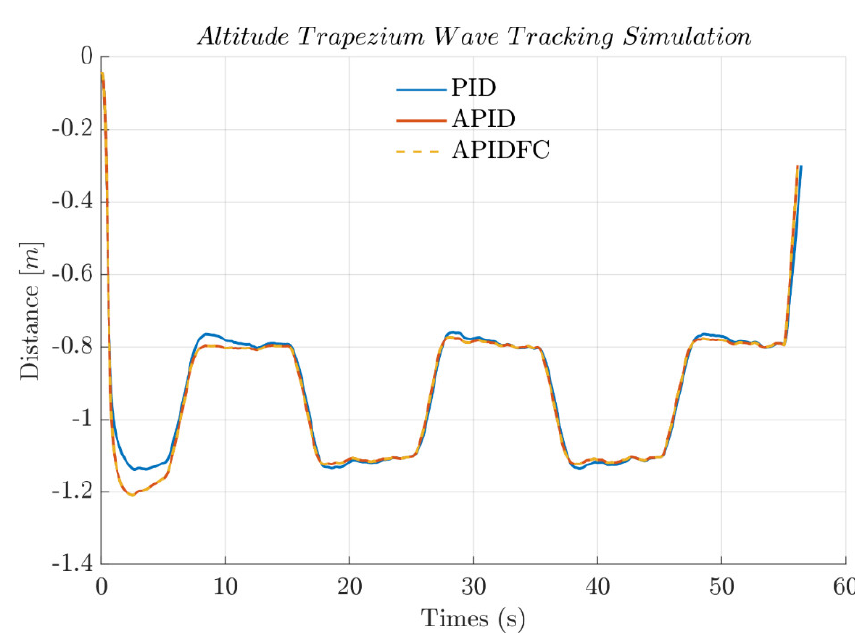
Figure 10. Trapezium wave tracking in the simulation.